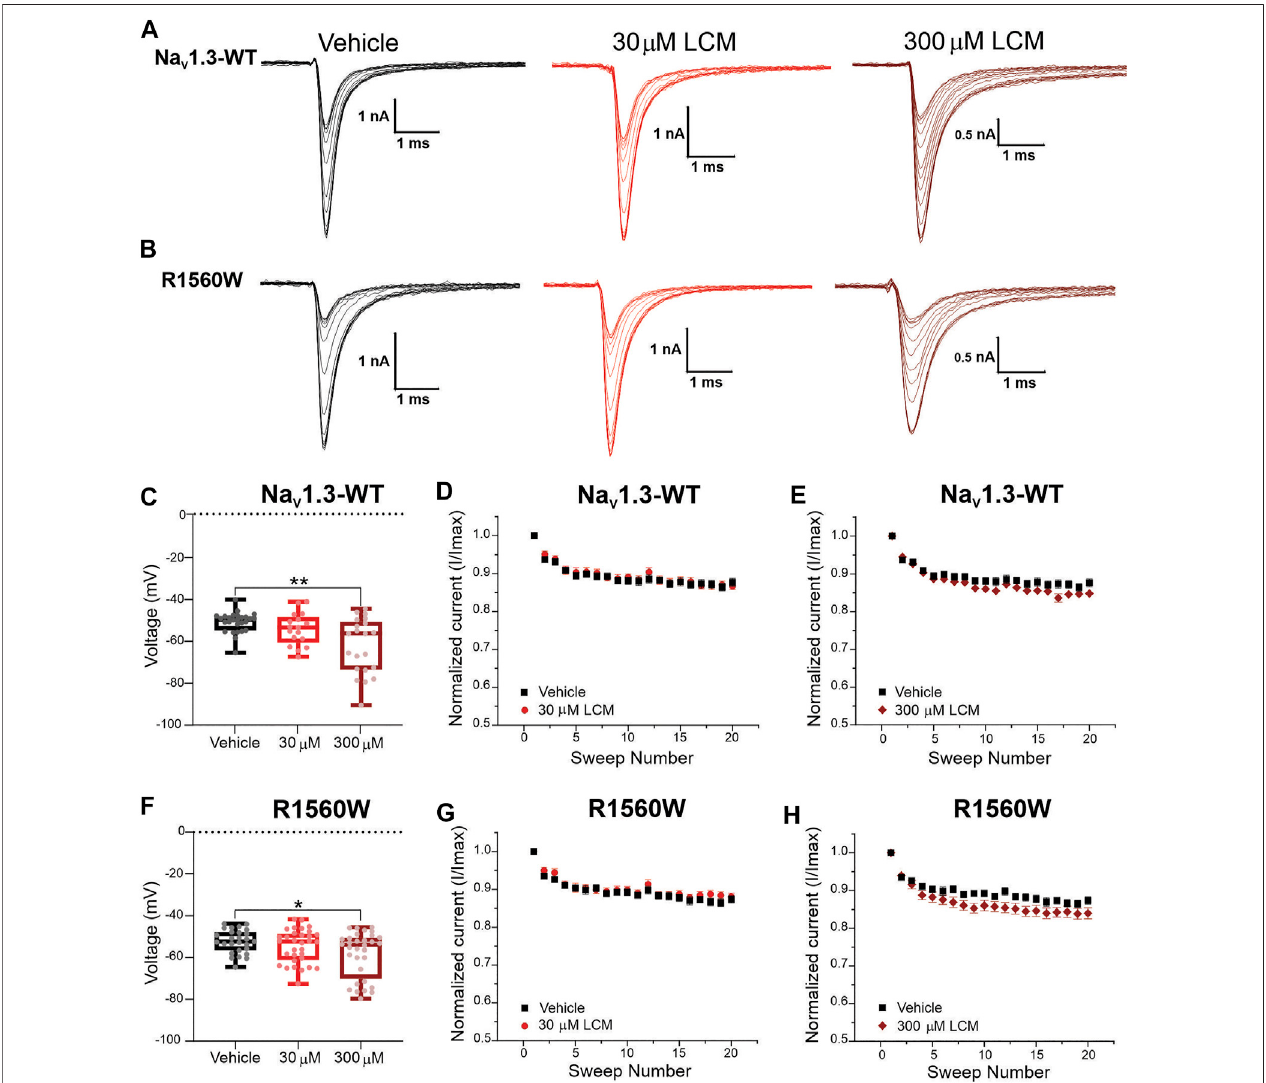
FIGURE6| TheNa V 1.3-R1560Wmutationinisnotsuf fi cienttoconferlacosamidesensitivitytoNa V 1.3channels.TheR1560residueinNa V 1.3,whichcorresponds totheW1538RmutationinNa V 1.7,wasmutatedfromanarginine(R)toatryptophan(W)tomatchthesequenceofNa V 1.7WTatthissite,andtheresponsivenessofthe Na V 1.3-R1560W to lacosamide. (A,B) Representative sodium current traces were generated from the activation protocol and show Na v 1.3-WT (A) and Na v 1.3- R1560W (B) currents in response to vehicle (black), 30 μ M (red) and 300 μ M (dark red) lacosamide. Dose-dependent effects of 30 and 300 μ M lacosamide were measured for (C – F) slow-inactivation and (D,E,G,H) use-dependence of inhibition at 20 Hz for human Na V 1.3-WT and Na V 1.3-R1560W channels using an